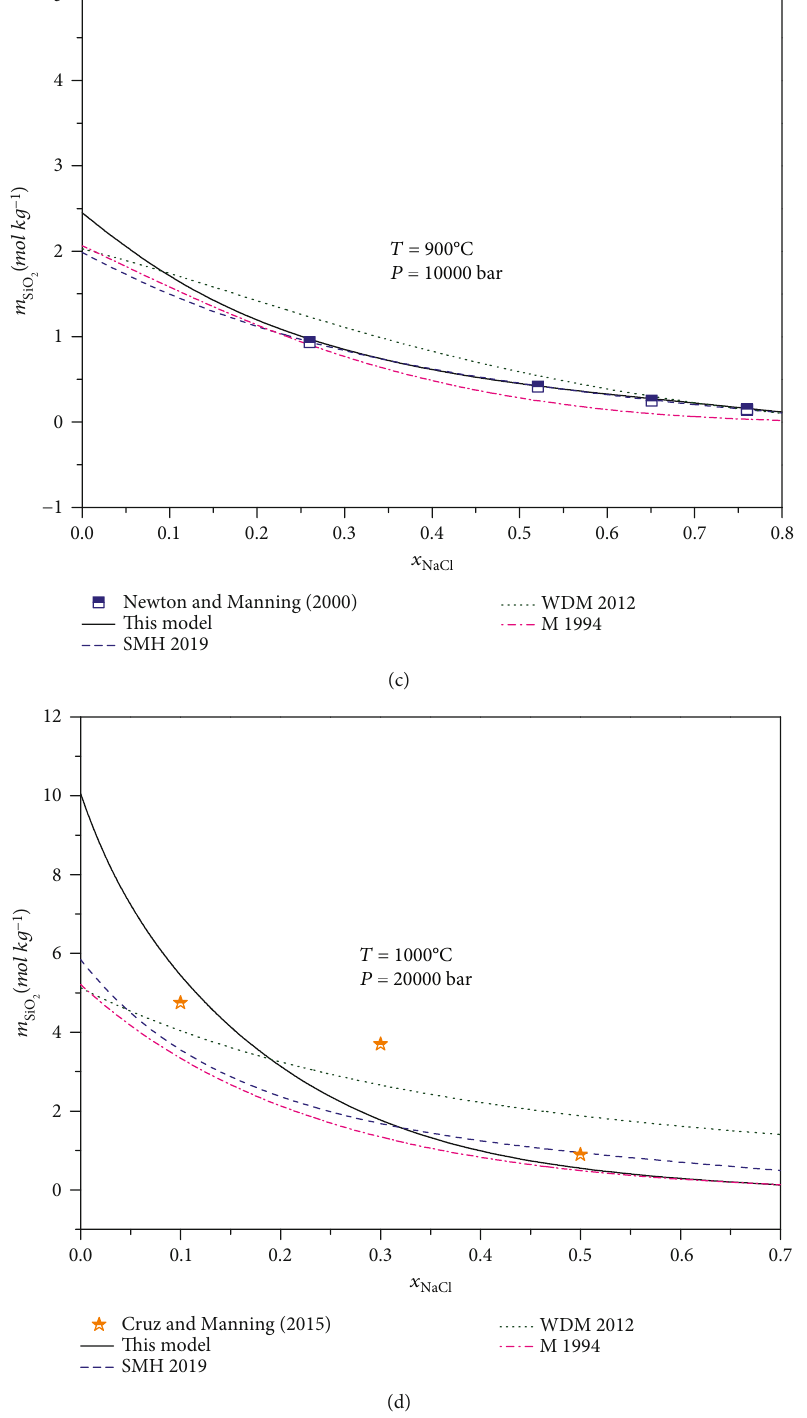
O-NaCl system. The solid curves, dash curves, dot 2